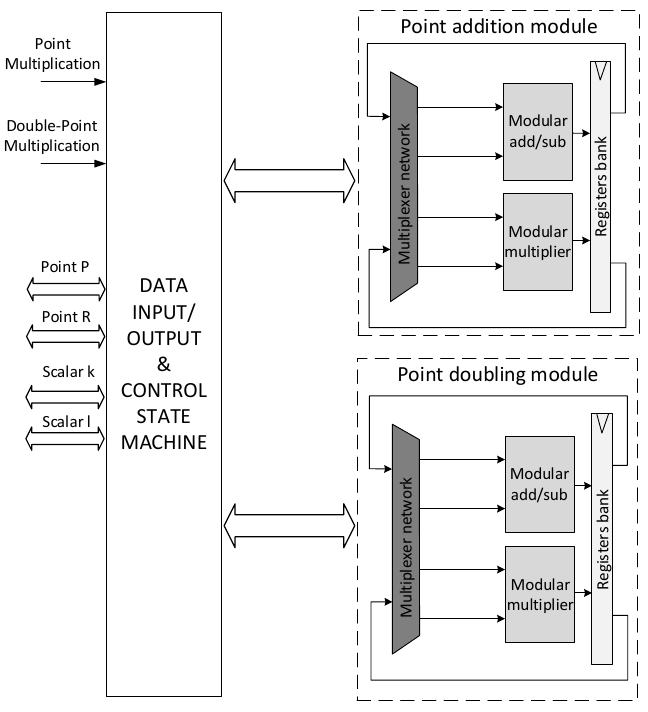
Figure 5. Overall Architecture of the proposed ECC